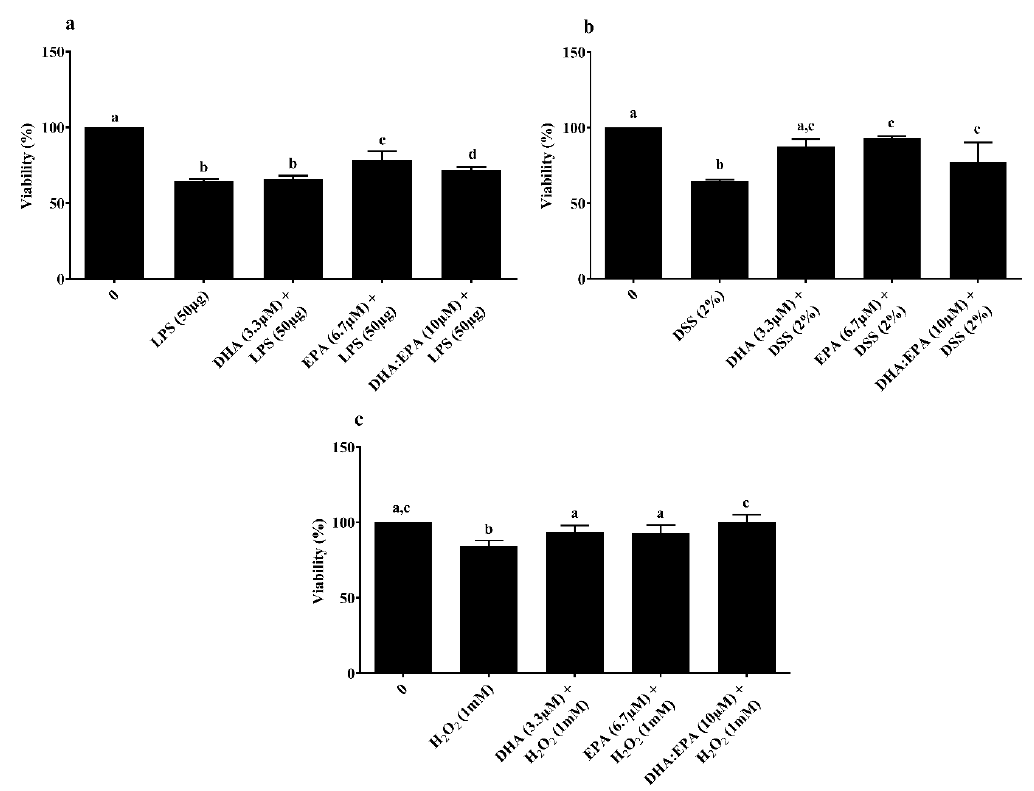
Figure 3. E ff ects of DHA (3.3 µ M), EPA (6.7 µ M) and DHA:EPA (1:2; 10 µ M) pre-treatment (24 h) Figure 3. Effects of DHA (3.3 μ M), EPA (6.7 μ M) and DHA:EPA (1:2; 10 μ M) pre-treatment (24 h) on